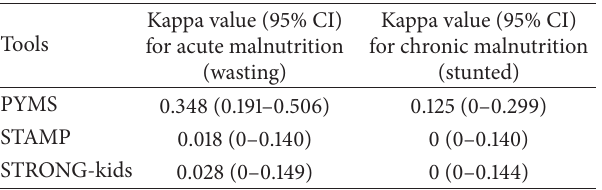
Table3:KappavaluebetweeneachofthescreeningtoolsandSGNA compared to acute/chronic